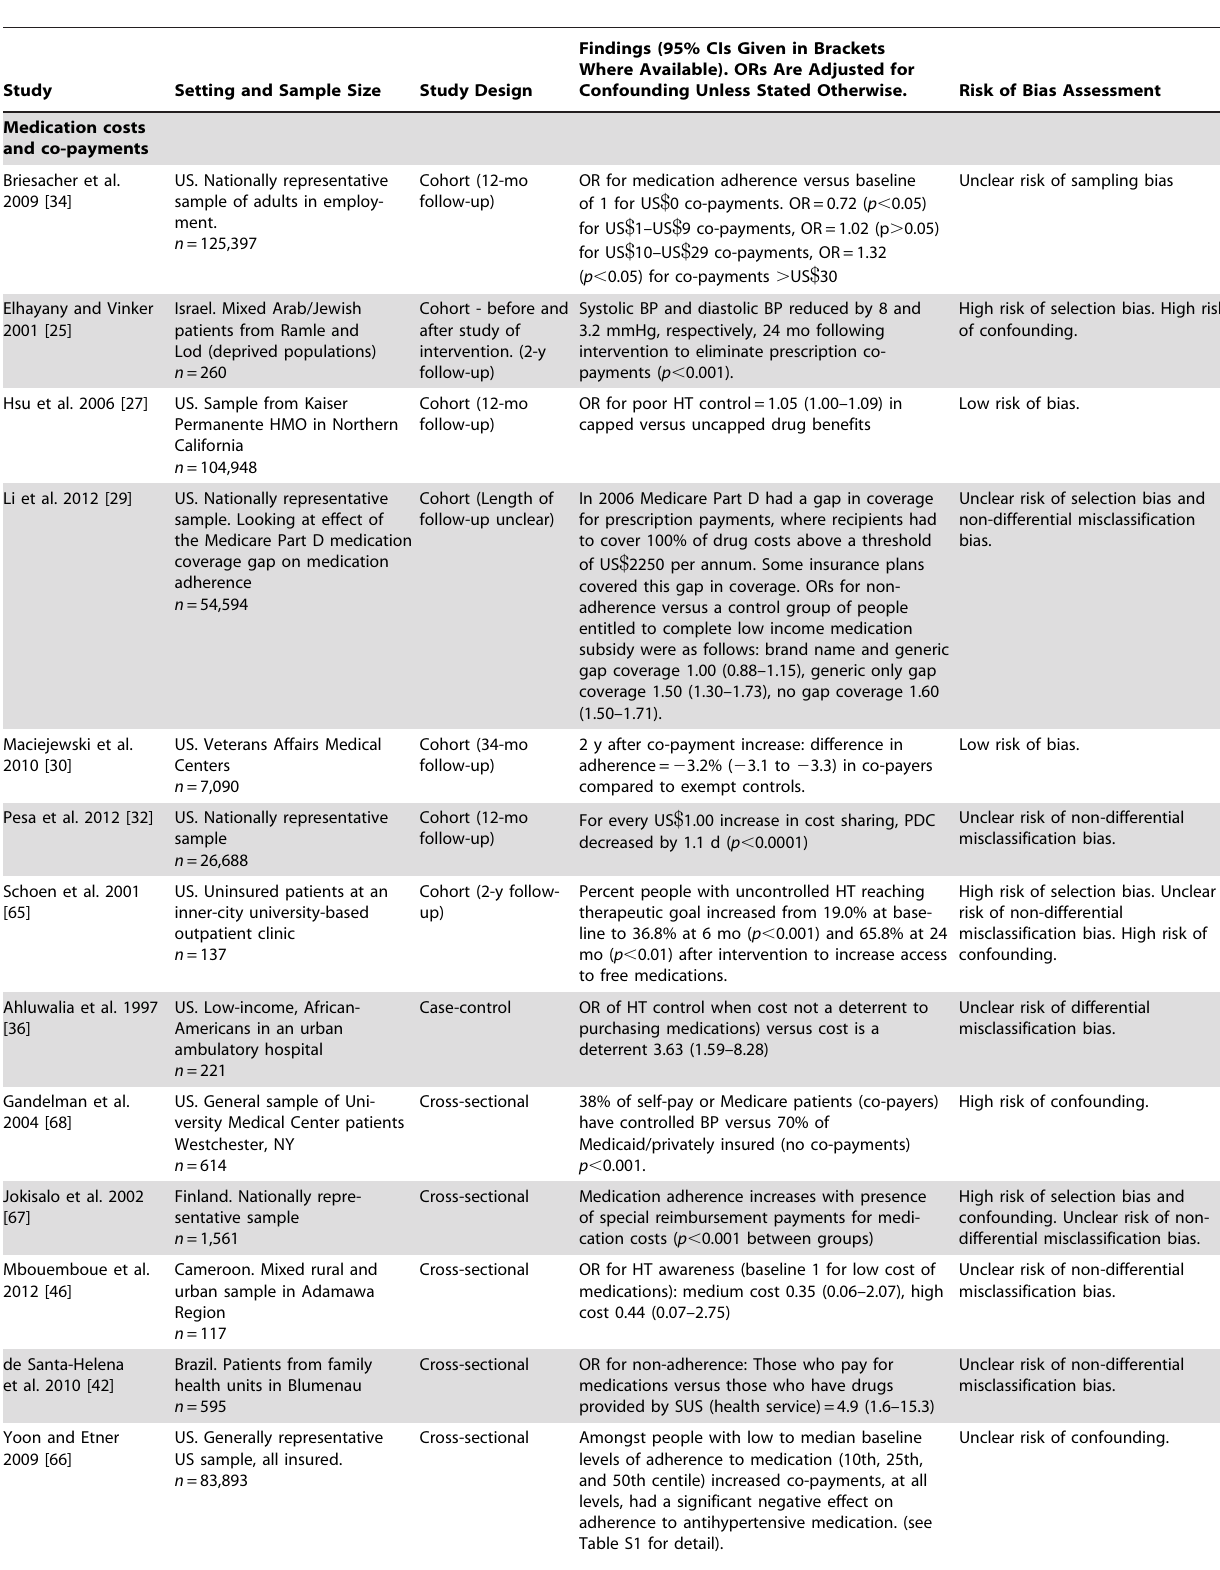
Table 4. Findings of quantitative studies examining the association of medication or medical care costs or co-payments with hypertension